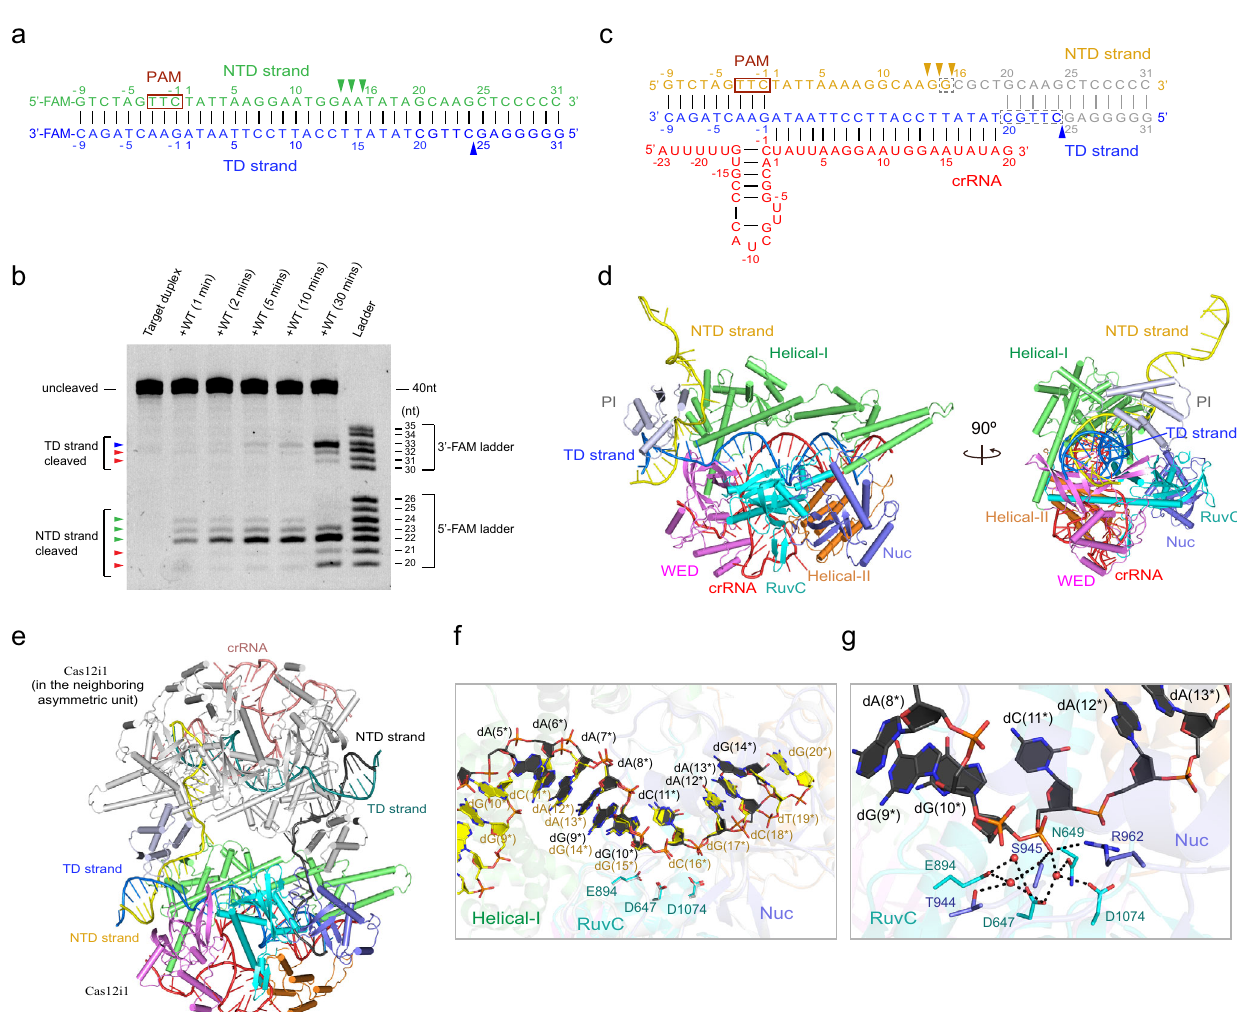
Fig. 4 Crystal structure of the Cas12i1 post-cleavage R-loop complex. a Schematic representations of the fl uorescently labeled target duplex used in the cleavage assays. Green and blue triangles indicate the cleavage sites within the NTD and TD strands, respectively. b Denaturing gel demonstrating the time-course cleavage of the fl uorescently labeled target duplex by wild-type Cas12i1 in complex with crRNA. The cis -cleavages of the NTD and TD strands are labeled with the green and blue triangles, respectively, and the trans -cleavages are labeled with the red triangles. The cleavage assays were repeated three times independently to con fi rm the repeatability and source data are provided as a Source data fi le. c Schematic representation of the R-loop structure after target DNA cleavage. Yellow and blue triangles indicate the cleavage sites within the NTD and TD strands, respectively. Nucleotides colored in gray represent the PAM-distal cleavage product that was released from the complex. Disordered regions are encircled by gray dashed lines. d Overall structure of the Cas12i1 post-cleavage R-loop complex shown in two different orientations, color-coded as de fi ned in Fig. 1. e The cleaved NTD strand of the Cas12i1 post-cleavage R-loop complex is extended into the RuvC active site of the neighboring complex from another asymmetric unit and vice versa. Each asymmetric unit contains one post-cleavage R-loop complex. f , The overlay of the unpaired NTD strand from the pre-cleavage R-loop complex and the unpaired NTD strand from the neighboring complex extended into the post-cleavage R-loop complex. The pre-cleavage R-loop complex is colored as in Fig. 1. The neighboring unpaired NTD strand and Cas12i1 in the post-cleavage R-loop complex are colored black and silver, respectively. g Detailed interactions between the neighboring unpaired NTD strand and the RuvC active site of the post-cleavage R-loop complex. The fi gure is colored as in ( e